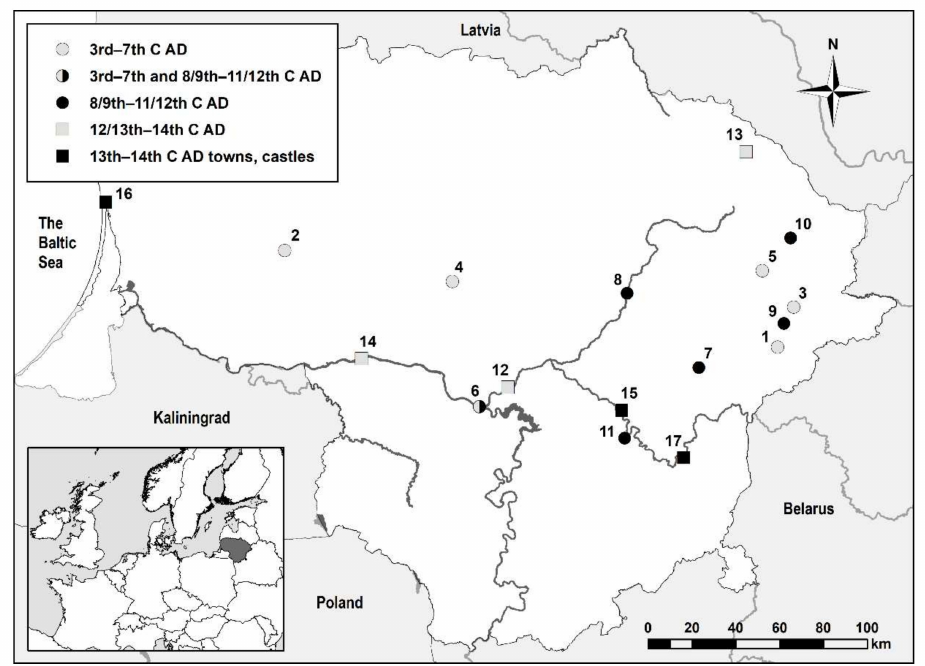
Figure 1. Location of sites mentioned in the